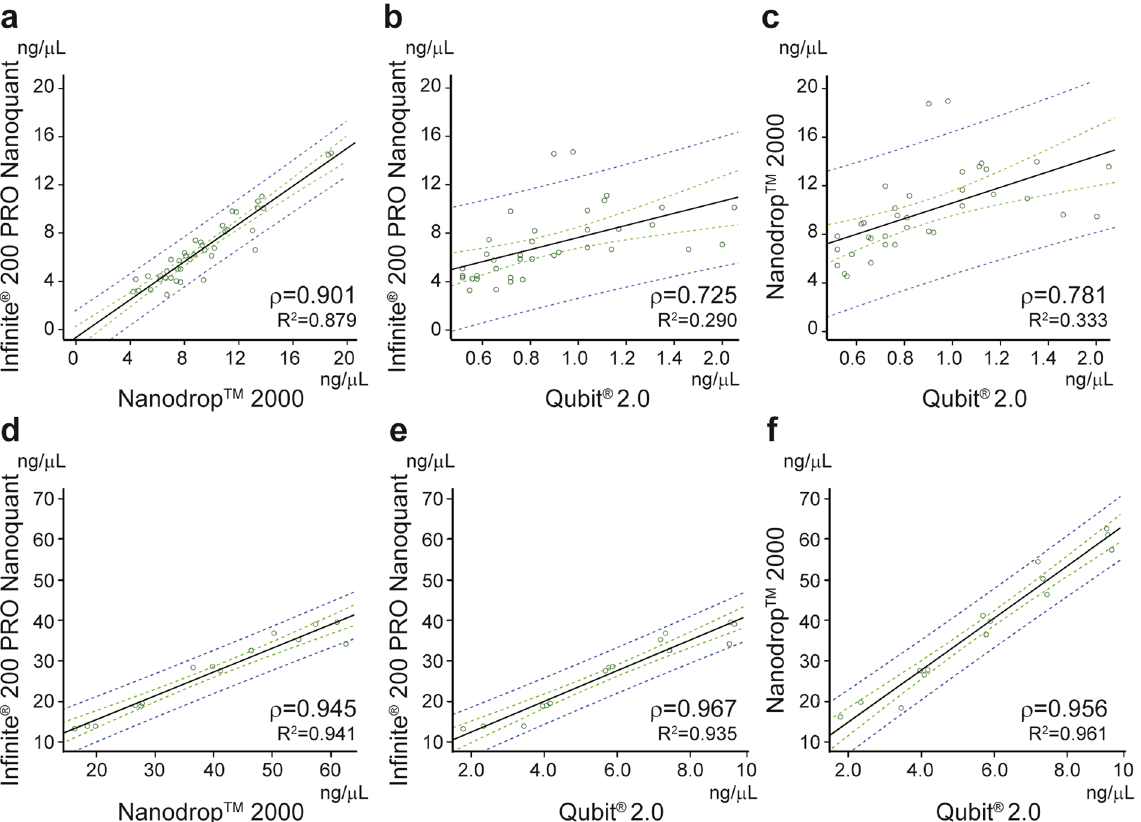
Figure 4. Correlations between Nanoquant, Nanodrop and Qubit. Correlations between techniques using original and diluted plasma samples ( a – c ). Correlations between techniques using concentrated plasma samples ≥ 2 ng/ µ L ( d – f ). Regression lines (black) with their 95% confidence interval (dashed green) and 95% prediction interval (dashed blue) were generated from the correlation of n = 41 ( a – c ) and n = 15 ( d – f ) quantification values. Correlations were assessed with Spearman rank correlation coefficient ( ρ ) and linear regression R 2 . Concentrations are expressed in ng/ µ